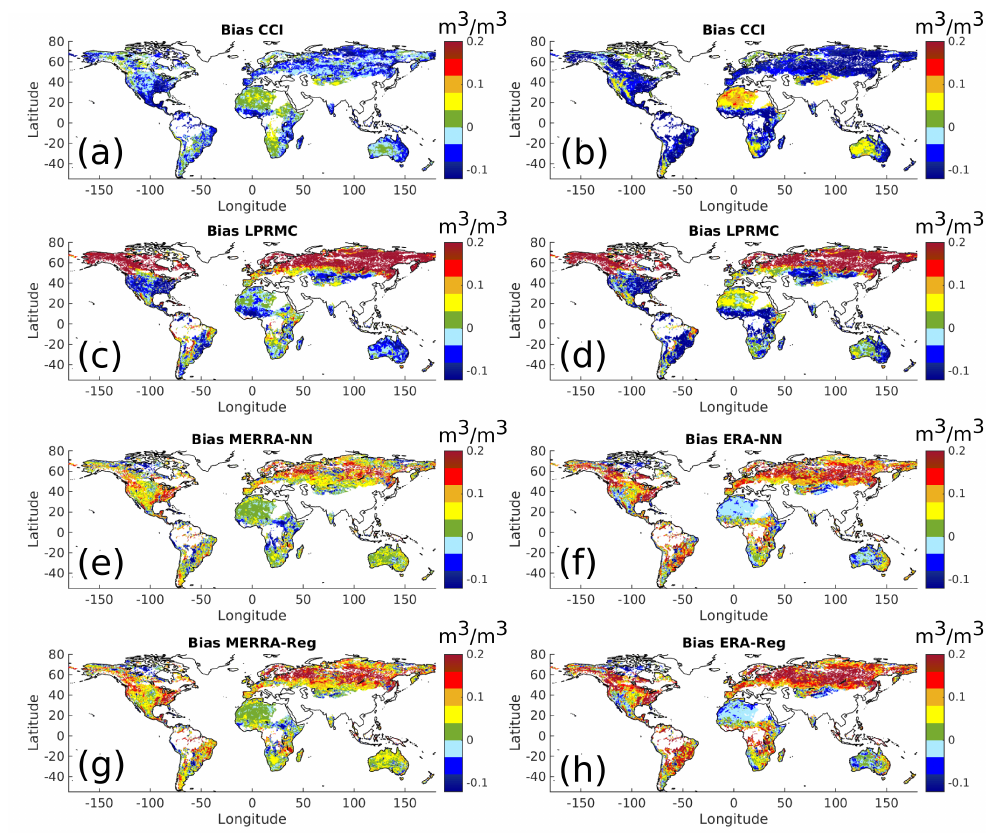
Figure 9. Bias of remote sensing products with respect to MERRA-Land (left panels) and ERA-Land (right panels). The remote sensing products evaluated are, from top to bottom: ESA CCI ( a , b ); AMSR-E LPRM C-Band ( c , d ); AMSR-E NN ( e , f ); and AMSR-E Reg ( g , h ). The bias has been computed as the mean of the remote sensing data minus the mean of model data, except for AMSR-E Reg and NN, for which the bias shown is the mean of the model data minus the mean of the remote sensing